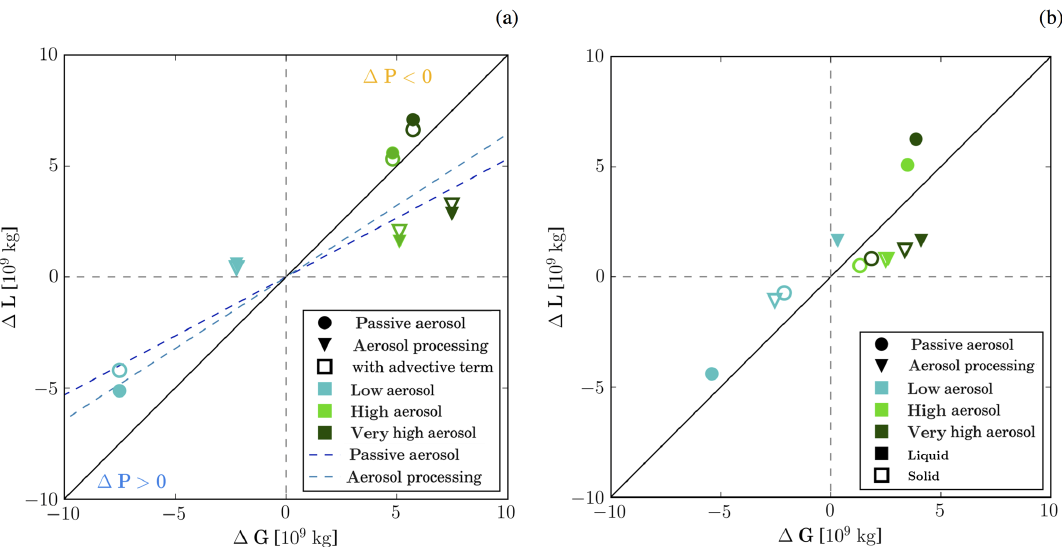
Figure 8. (a) Scatterplot of change in condensate gain (cid:49)G and loss (cid:49)L relative to the simulation with the standard-aerosol profile. Points falling above the one-to-one line (solid black line) portray a decrease in surface precipitation, while points below it portray a surface pre- cipitation increase. For points in the area between the solid black line and the dashed lines (dark blue: passive aerosol, light blue: aerosol processing) the change in condensate generation dominates over the change in PE (Appendix A). The impact of advection of condensed water out of the domain is illustrated by the open symbols. For these points the advective flux is discounted as loss. (b) Same as (a) , but separating contribution of condensation and evaporation (filled symbols) from contribution of deposition and sublimation (open symbols).